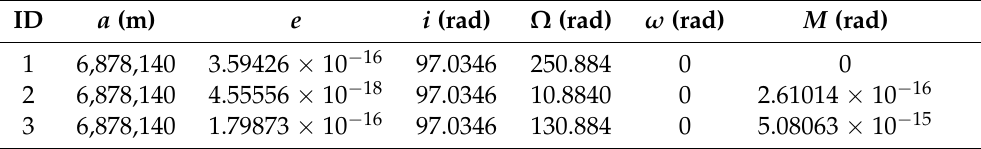
Table 3. Initial orbital elements of satellites.